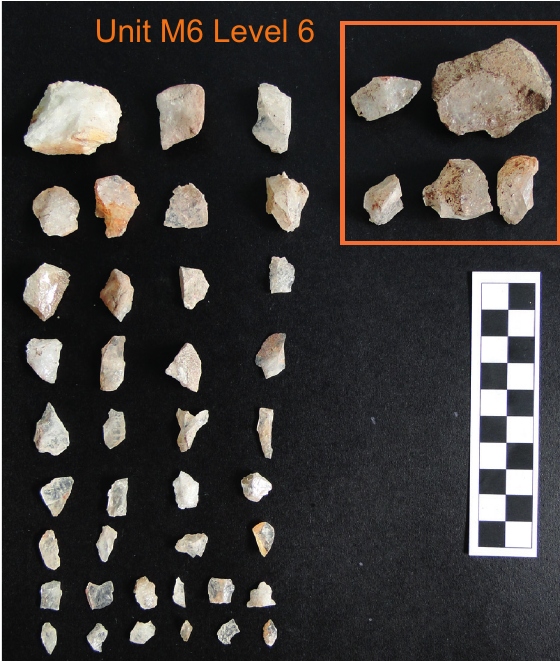
Figure 11 - Sample of cores (inside box) and flakes from Unit M6, Level 6, dated ca. 4400 cal BP.